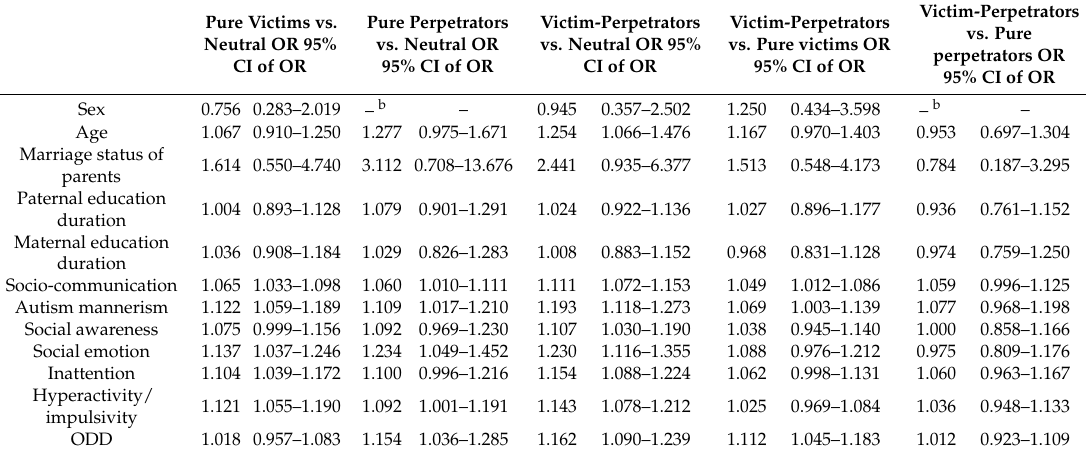
Table 4. The factors related to parent-reported bullying involvement: logistic regression a